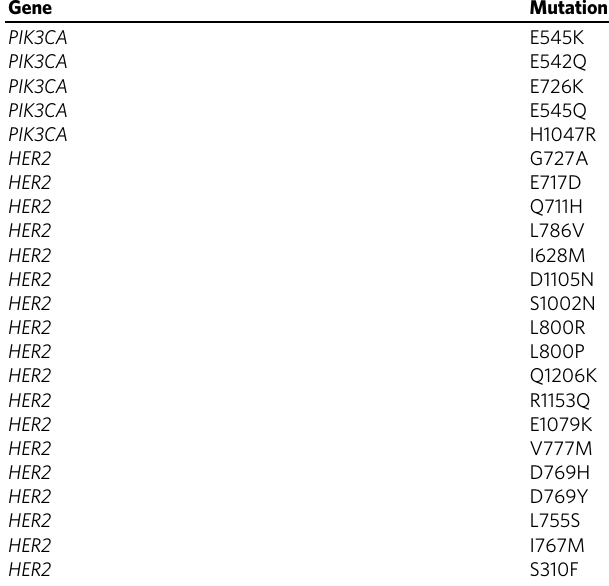
Table 1 PIK3CA and HER2 ( ERBB2 ) mutations identi fi ed within Guardant Health sequencing validated by droplet digital PCR